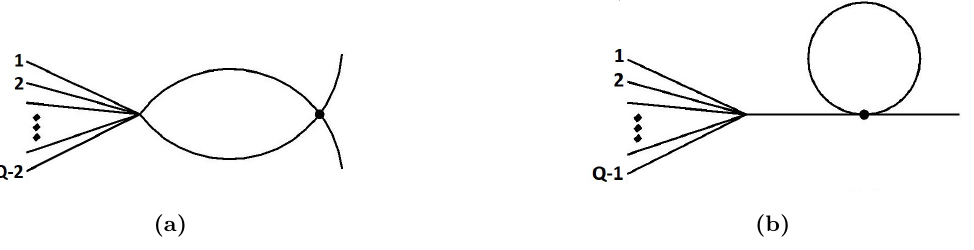
Figure 2. Feynman diagrams that contribute one-loop corrections to the anomalous dimen- sion